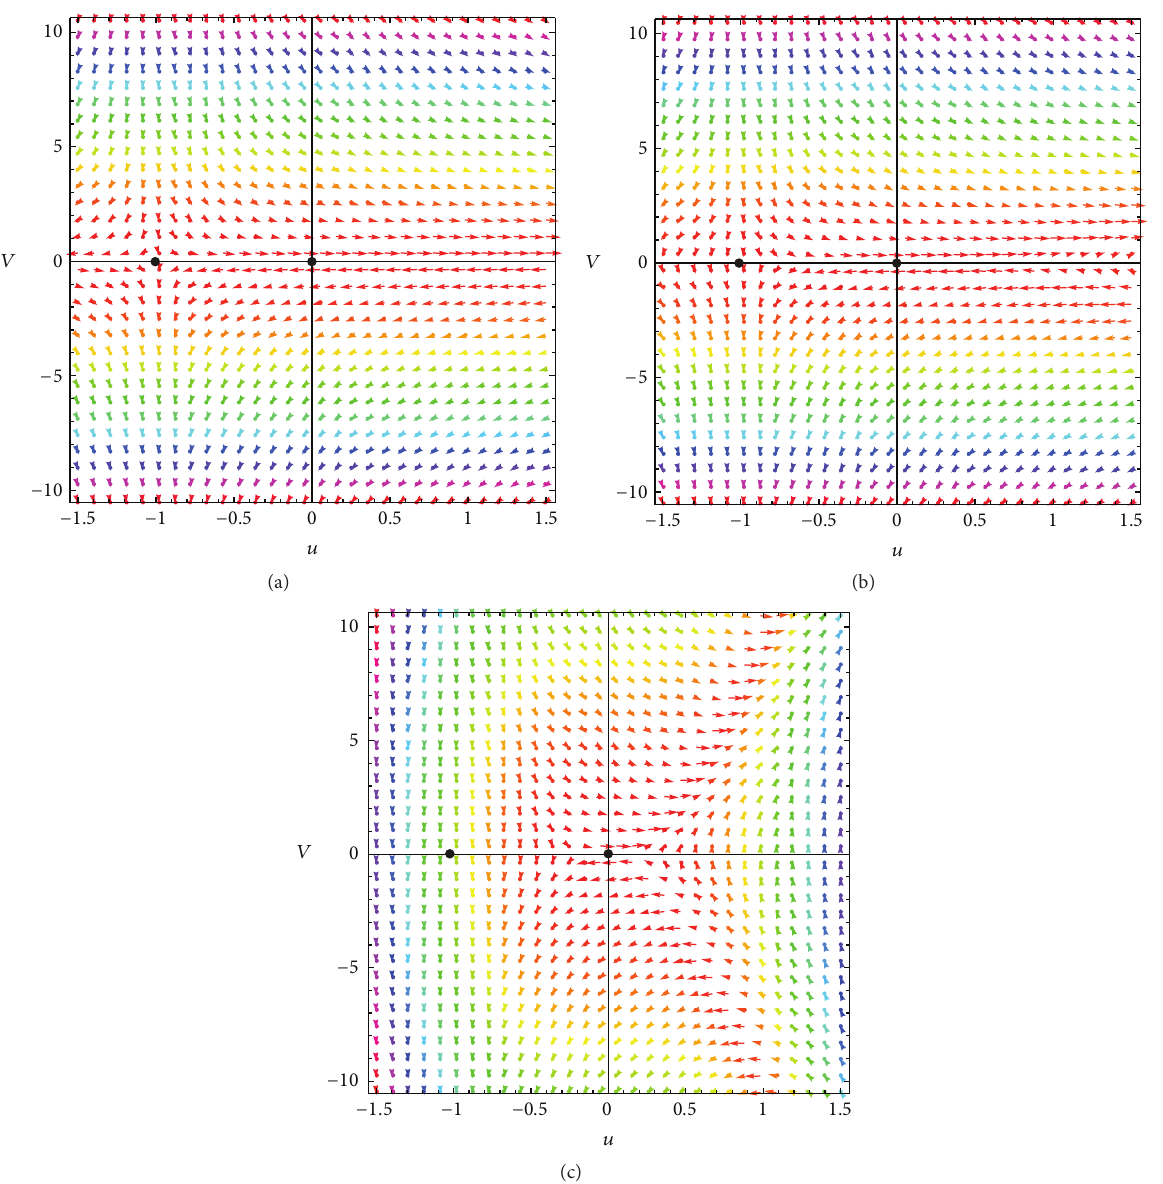
Figure 5: Plot of the phase trajectories for system (25) with M = 0.1 (a), M = 1 (b), and M = 10 (c) with 𝛽 = 1 and 𝑛 = 2 .